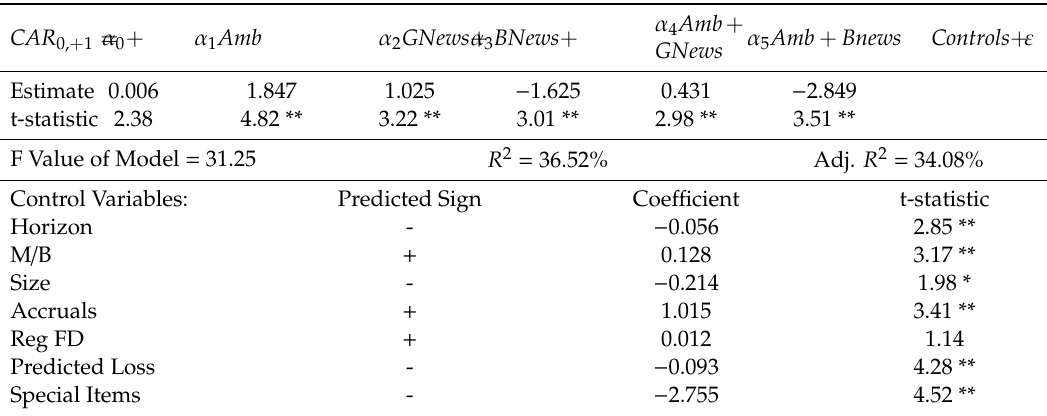
Table 4. The e ff ect of ambiguity on stock